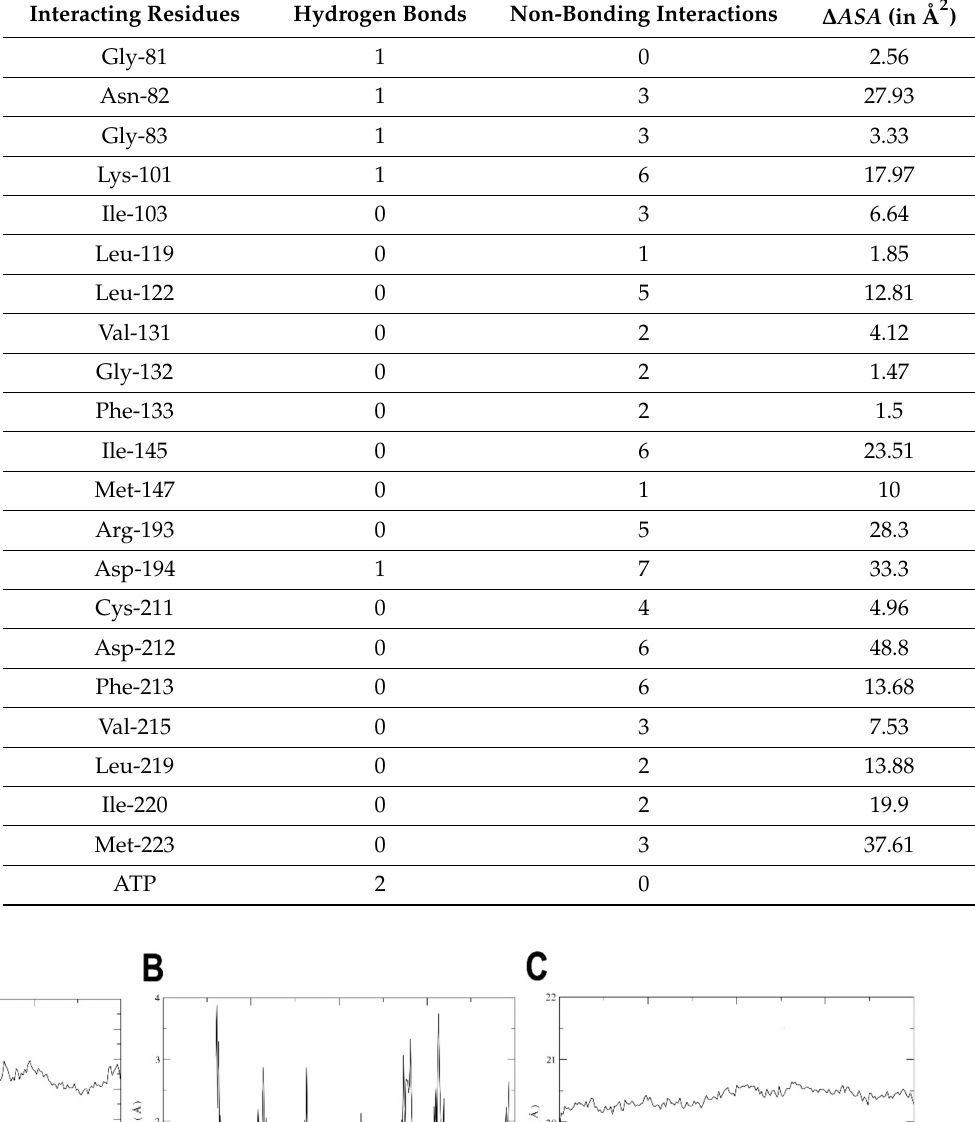
Table A10. The MEK2 residues interacting with selected flavonoid M2F10 are listed with the number of non-bonding interactions and ∆ ASA .